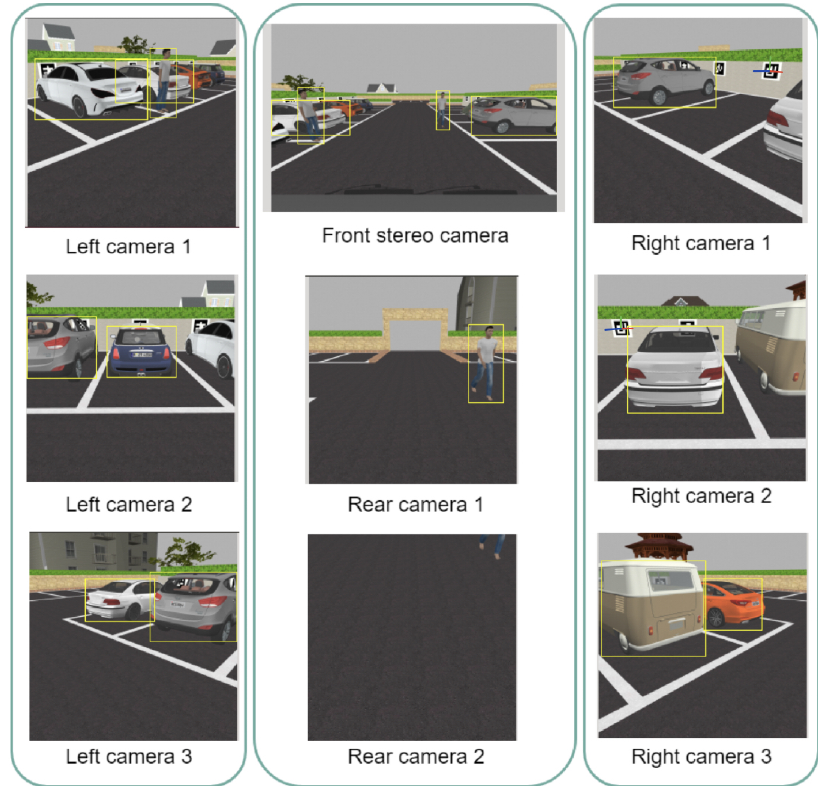
Figure 6. Pedestrians and cars recognized by the AV using camera sensors. “Right camera 1” and “Right camera 2” show the Aruco marker detection attached to the parking spaces. This can be combined with the occupancy grid generated by the LiDAR in Figure 7 to detect the free parking